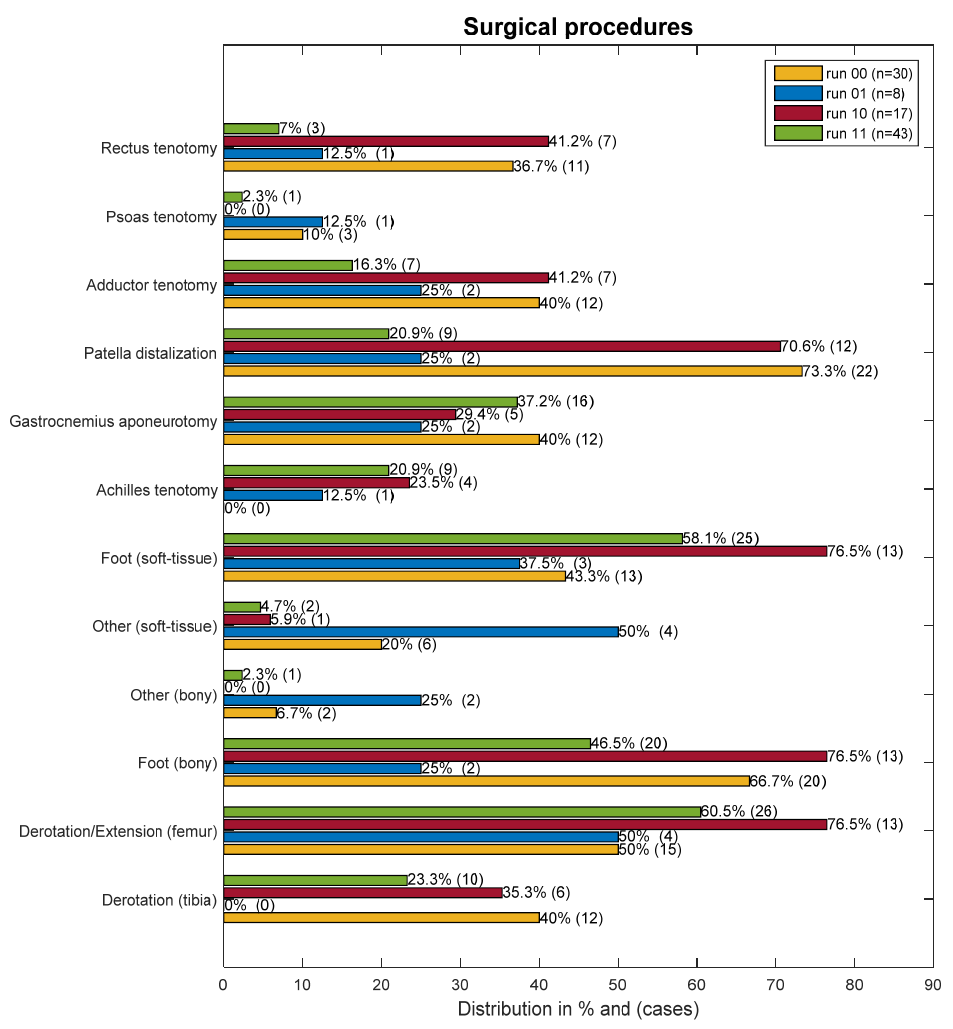
Figure 2. Overview of the surgical procedures in percent and number of incidences.